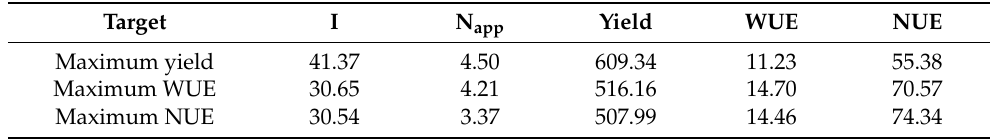
Table 5. Maximum yield (g plant − 1 ), water and nitrogen use efficiency of green pepper, and their corresponding irrigation amount and N app .